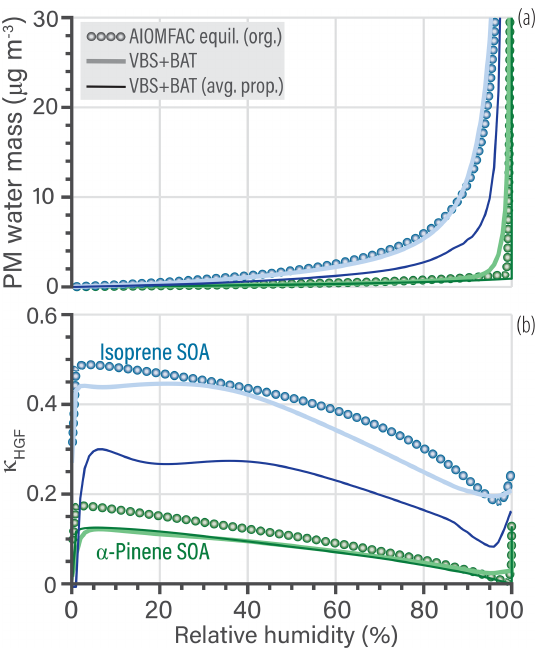
Figure 8. (a) Comparison of PM water mass as a function of bulk equilibrium relative humidity. The isoprene SOA simulation is shown in blue and the α -pinene SOA simulation in green. (b) The calculated κ HGF parameter of the organic mixture, which changes as a function of RH both due to nonideal mixing and organic co-